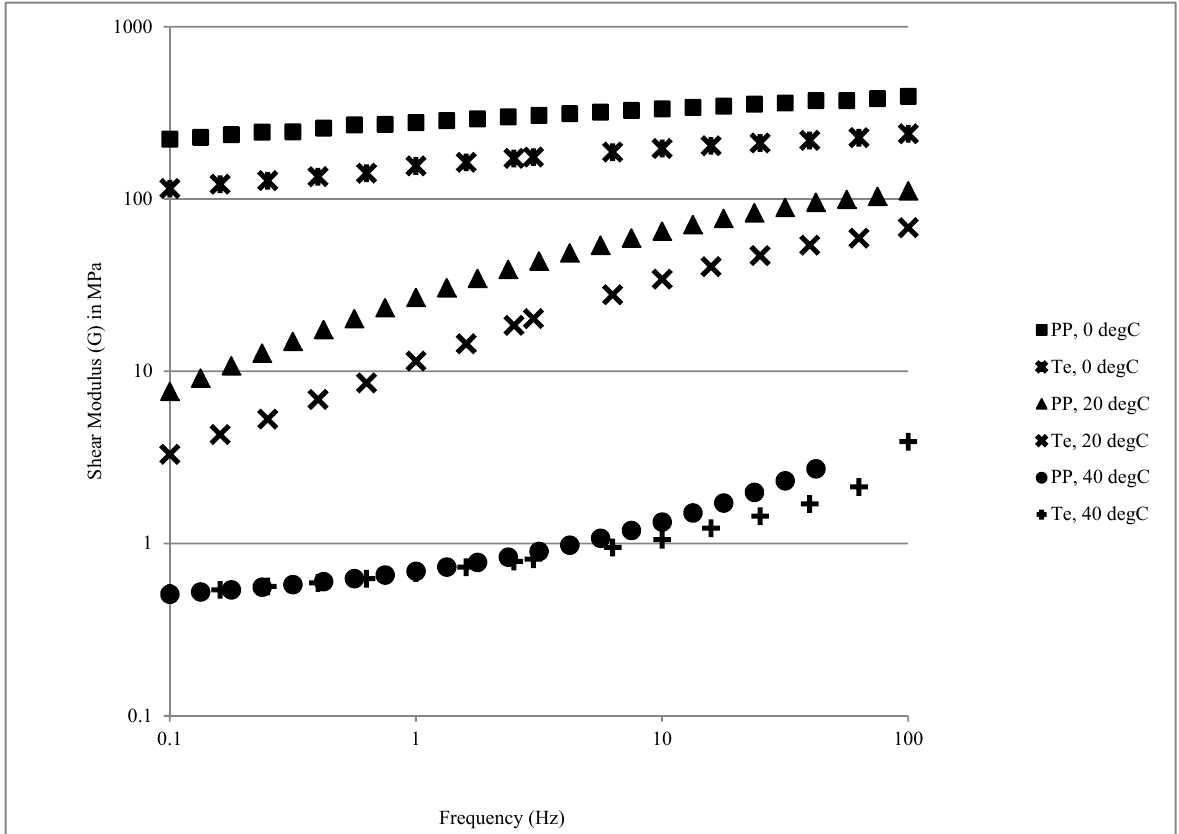
Fig. 5 Characterization of Saflex ® RB41 interlayer using two different deformation modes (PP refers to plate/plate geometry, Te to tensile